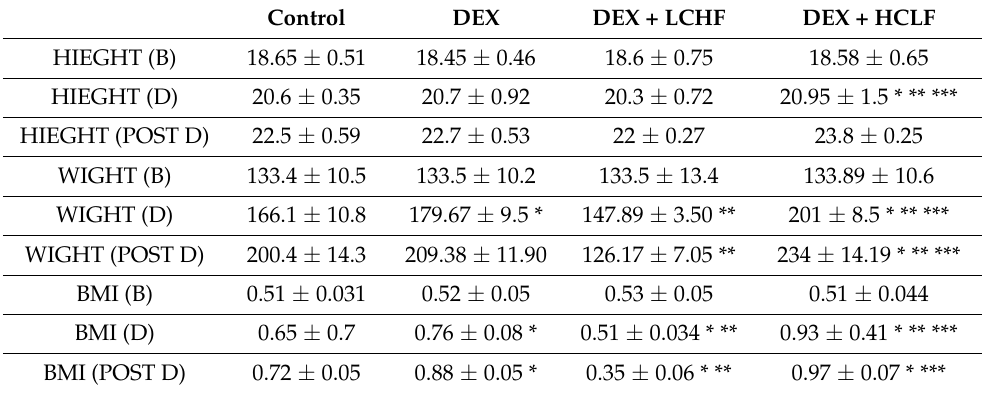
Table 2. The anthropometric parameters of all studied animal